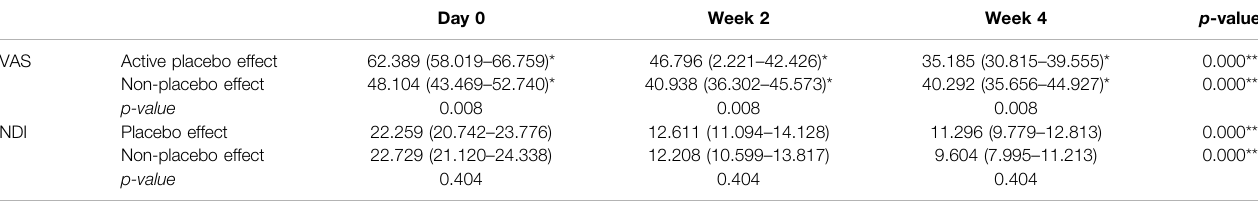
TABLE 4 | Summary and comparison of VAS and NDI at all the placebo-treatment